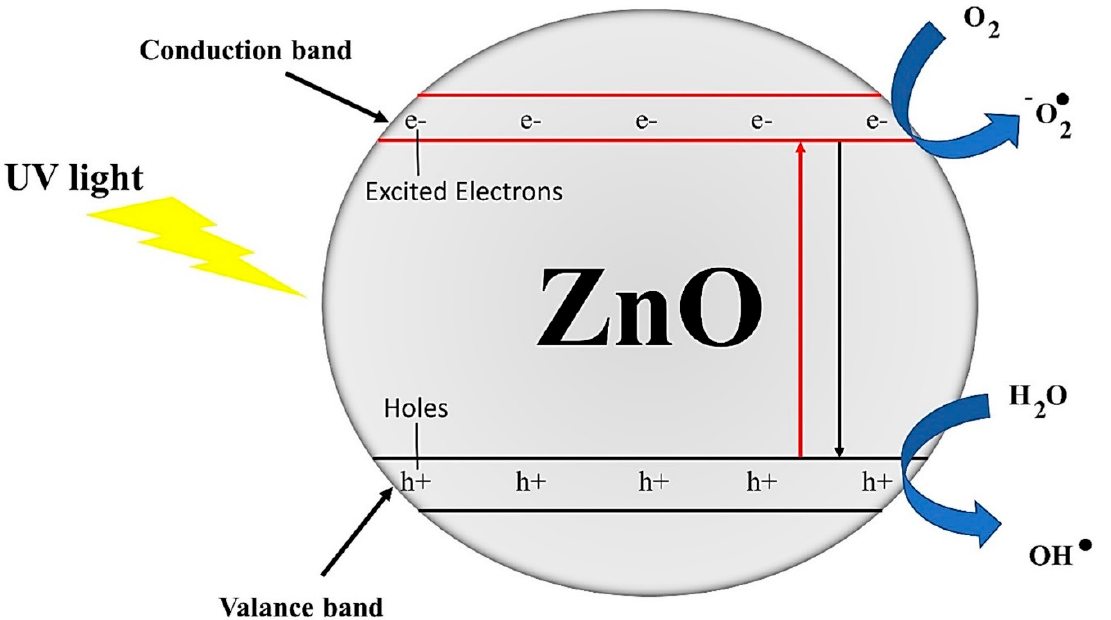
Figure 9. A typical mechanism of photocatalytic activity of pure nZnO. Reprinted with permission from Reference [70]. Copyright 2021, with permission from Elsevier.